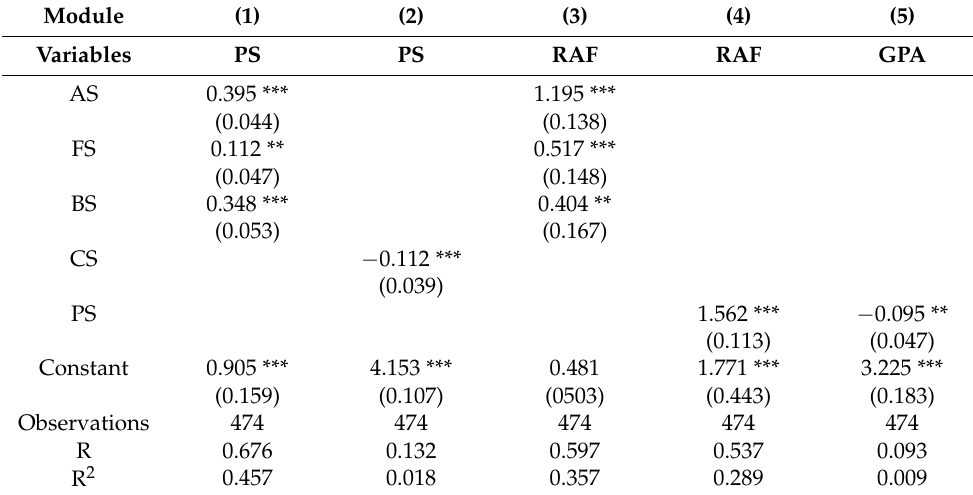
Table 8. Regression analysis Linear Regression Model Predicting Students’ Perceived Stress.